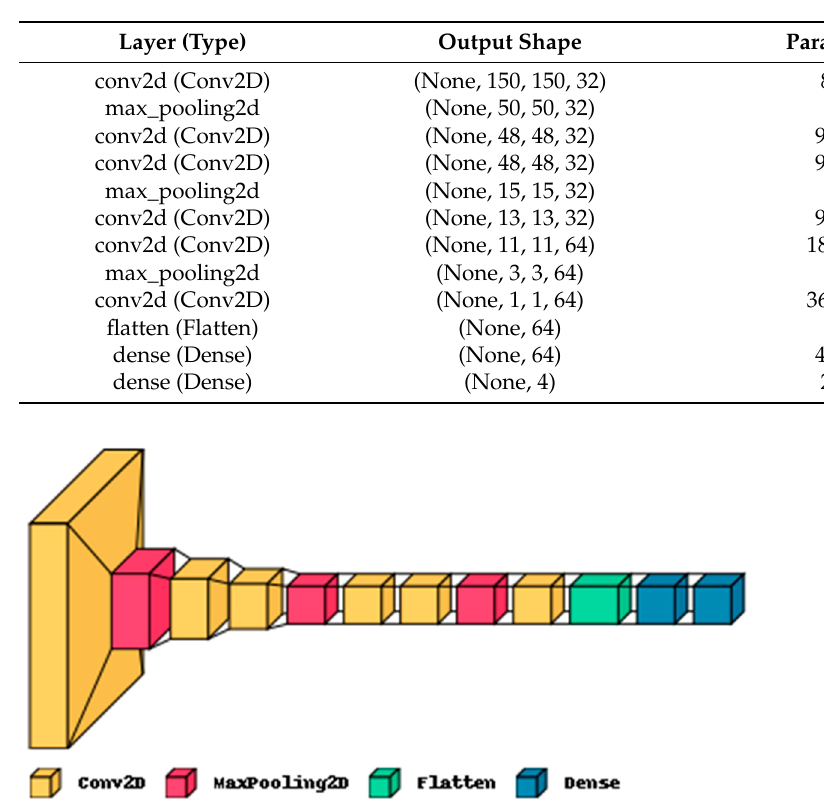
Figure 11. The visualized architecture of CNN model.